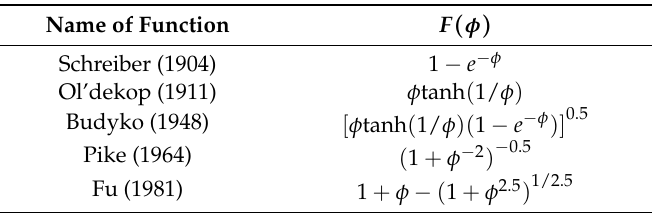
Table 2. Commonly-used Budyko